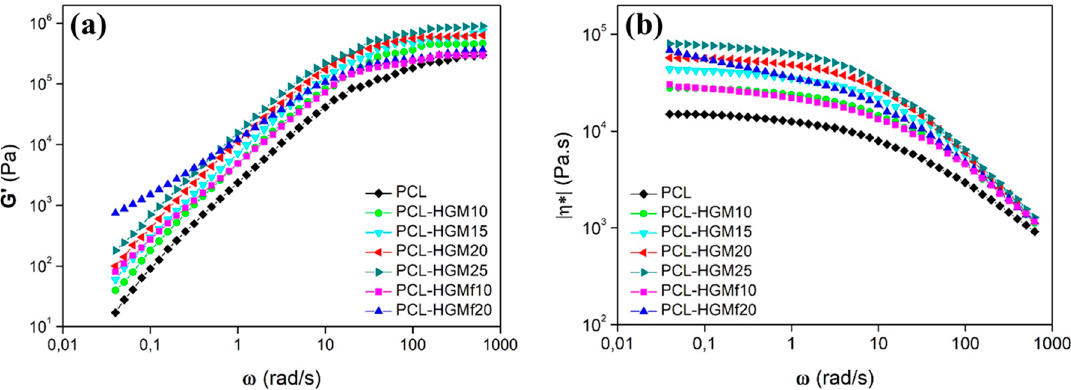
Figure 8. Storage modulus (G ′ ) ( a ) and complex viscosity ( η *) ( b ) vs. angular frequency ( ω ) for neat PCL and PCL-based composites.